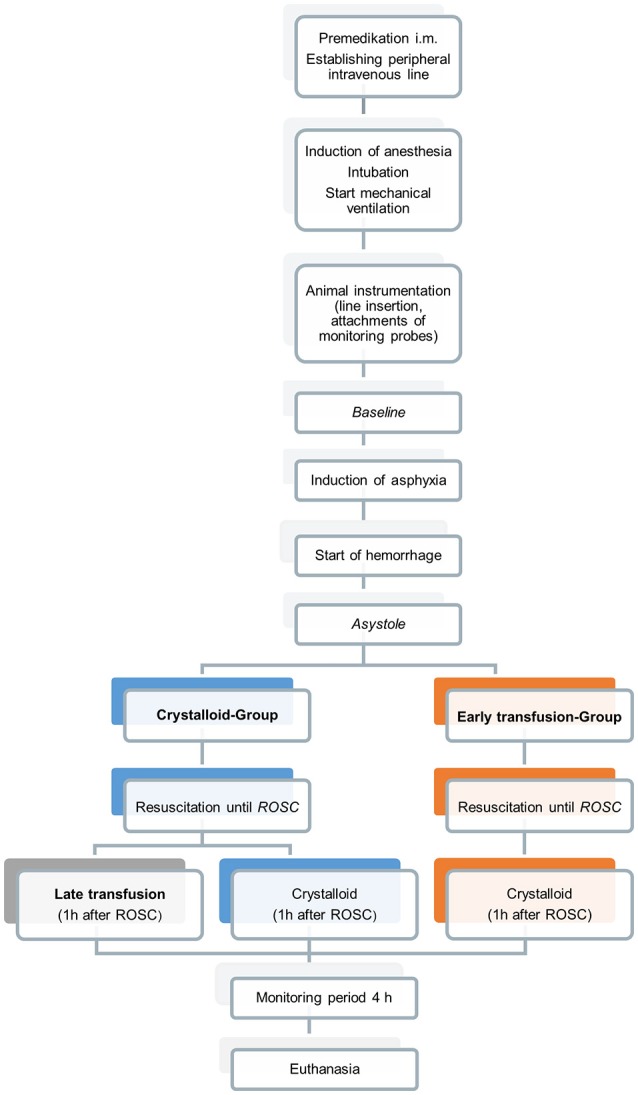
Experimental protocol.